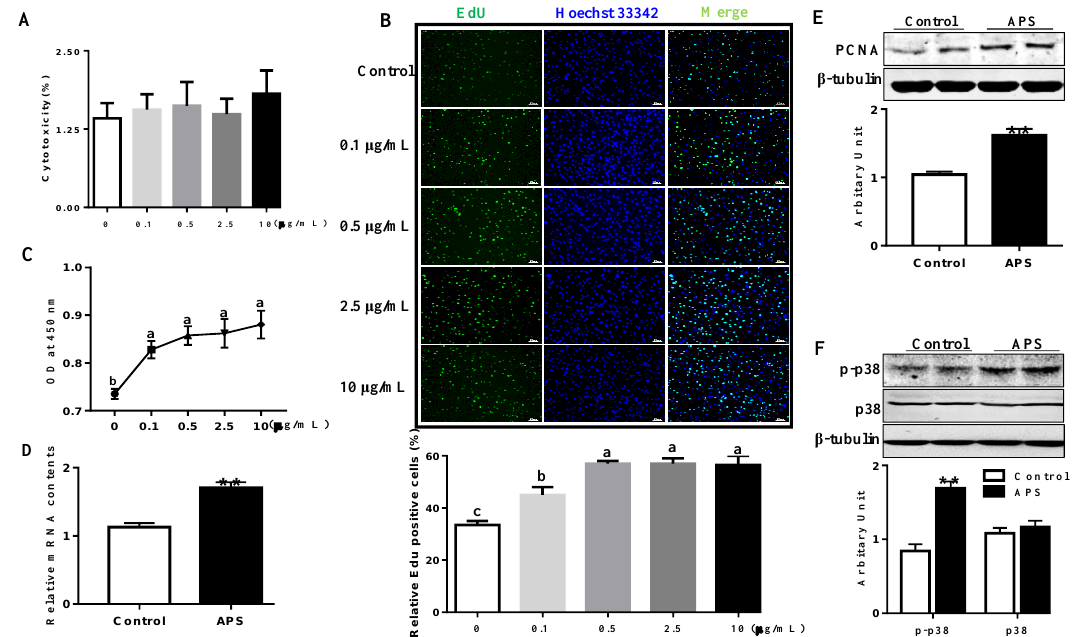
Figure 1. Astragalus polysaccharide (APS) promoted 3T3-L1 pre-adipocytes proliferation. ( A ) Cellular cytotoxicity under different concentration of APS was determined by lactate dehydrogenase (LDH) assay. ( B ) EdU staining, scar bar stands for 100 µ m. ( C ) Cell viability determined by Cell Counting Kit-8 (CCK8) assay. ( D ) mRNA expression of Proliferating Cell Nuclear Antigen (PCNA). ( E ) PCNA protein content. ( F ) p-p38 and p38 protein content. n = 6, ** p < 0.01. Different letters mean significant difference.